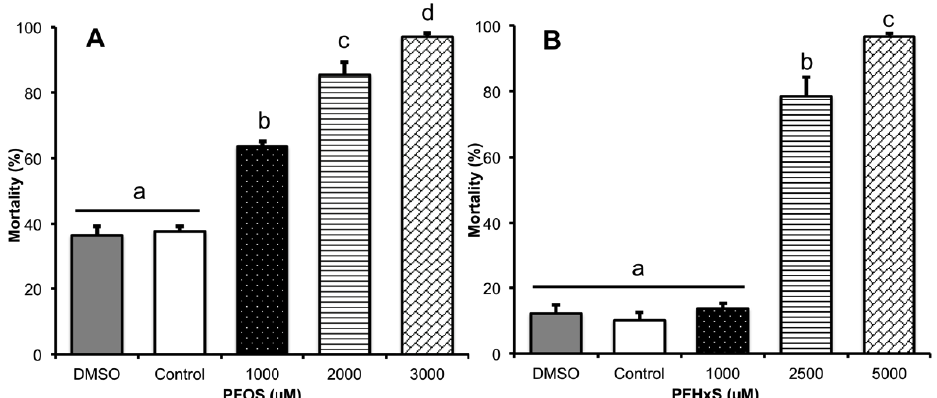
Figure 4. Mortality rates during boar spermatozoa in vitro capacitation process. ( A ) PFOS mortality increases significantly at all experimental concentrations evaluated. ( B ) PFHxS mortality is not significant at a concentration of 1000 µM, but it increases significantly at concentrations of 2500 and 5000 µM. Controls tested do not showed significant differences between them. Mortality data plotted correspond to eosin-nigrosin stain. All spermatozoa stained in pink by eosin (eosin positive) was considered dead, n = 6. a, b, c, d Different lowercase letters indicate the existence of significant differences between treatments ( p < 0.05).